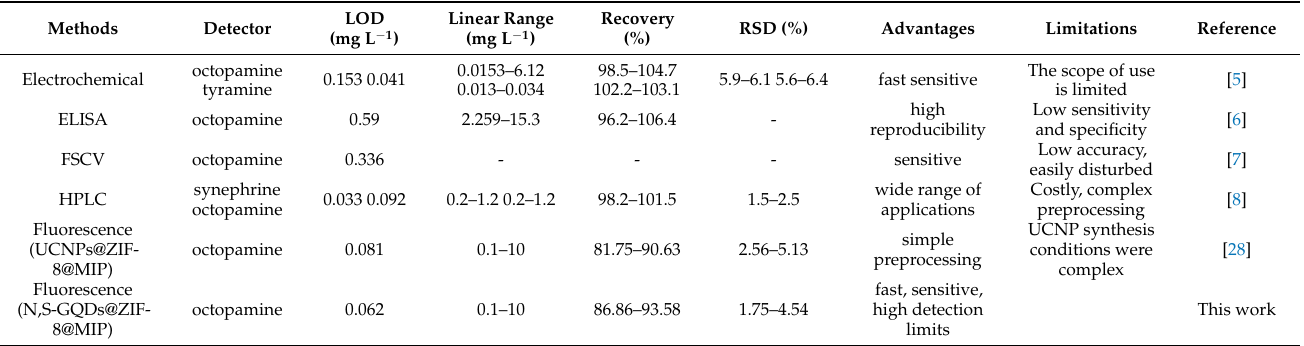
Table 2. Comparison of the proposed method with other methods reported in the literature.